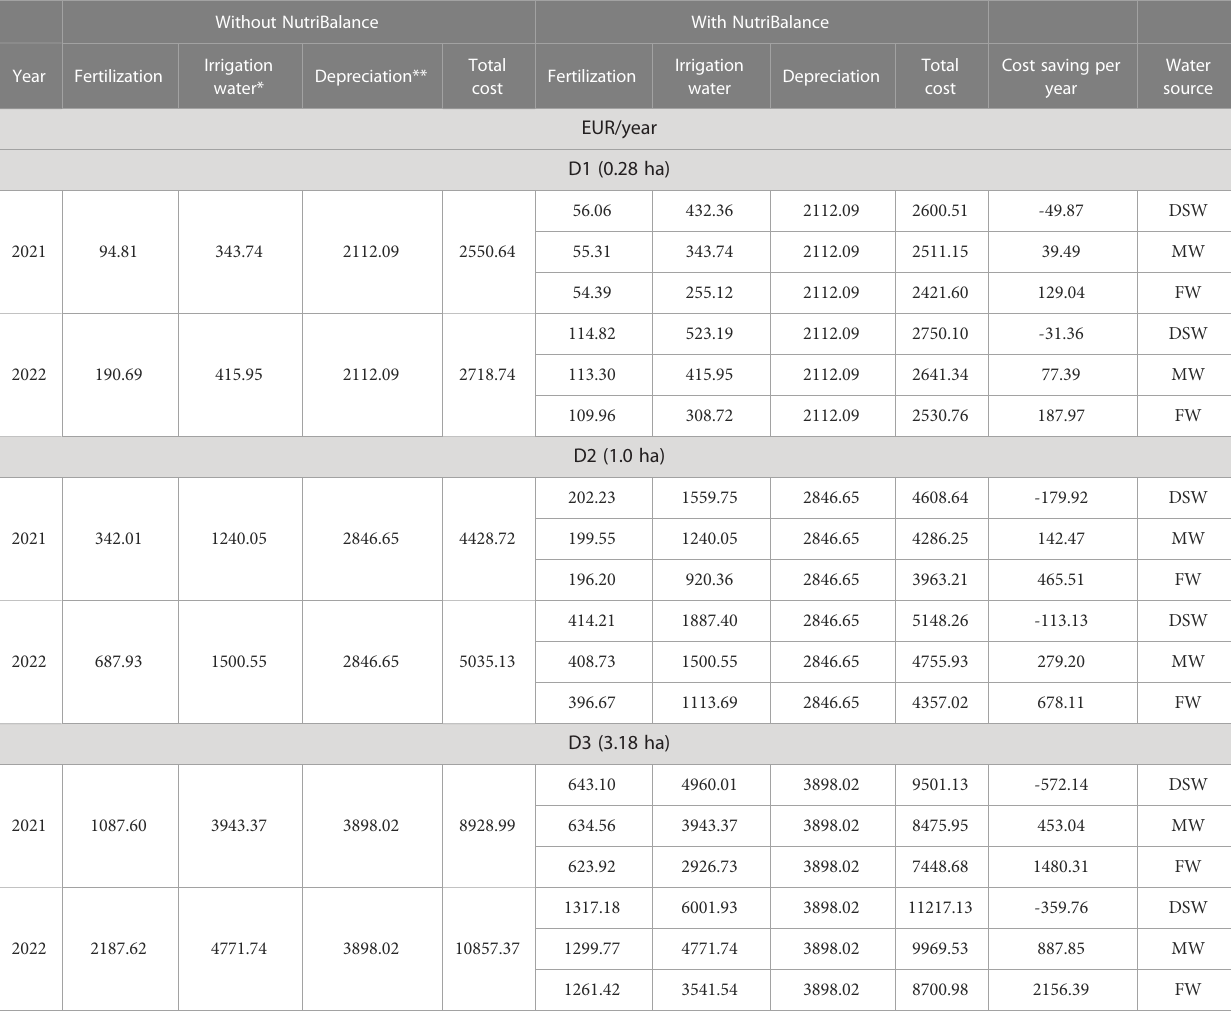
TABLE 4 Depreciation, water and fertilizer costs for D1, D2, and D3 irrigation systems. Without